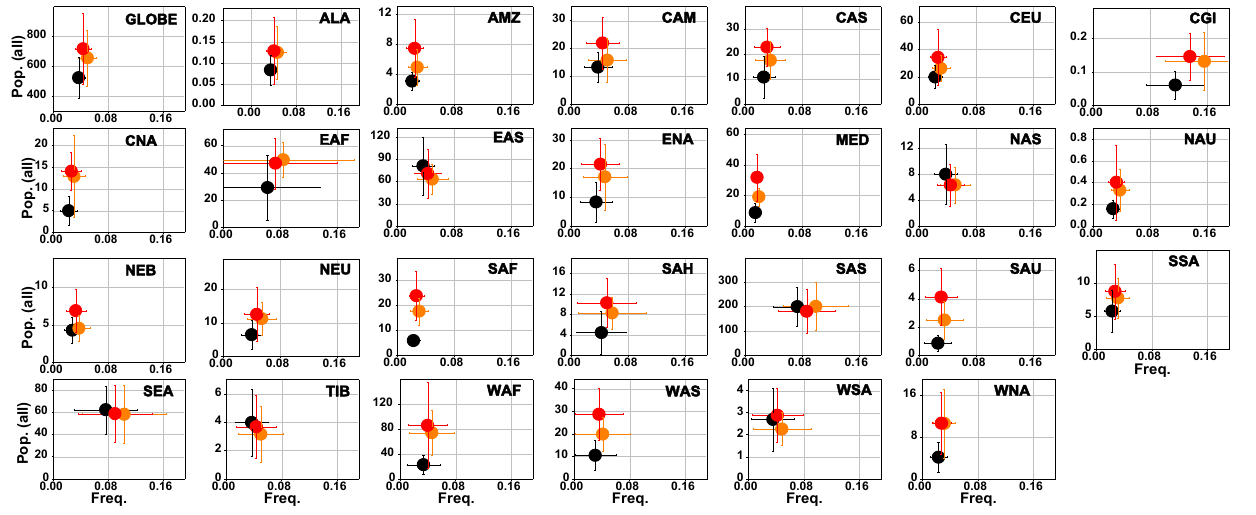
Figure 11. Multi-model projected frequency (Freq.) and affected total population (Pop., in millions) by severe drought (PDSI < − 3) globally and in 27 world regions for the baseline period (black, fixed SSP1 2000 population) and the 1.5 ◦ C (orange, fixed SSP1 2100 population) and 2 ◦ C (red, fixed SSP1 2100 population) warmer worlds. The projected uncertainties (standard deviation of multiple-model results) of multiple climate models are shown by error bars (horizontal and